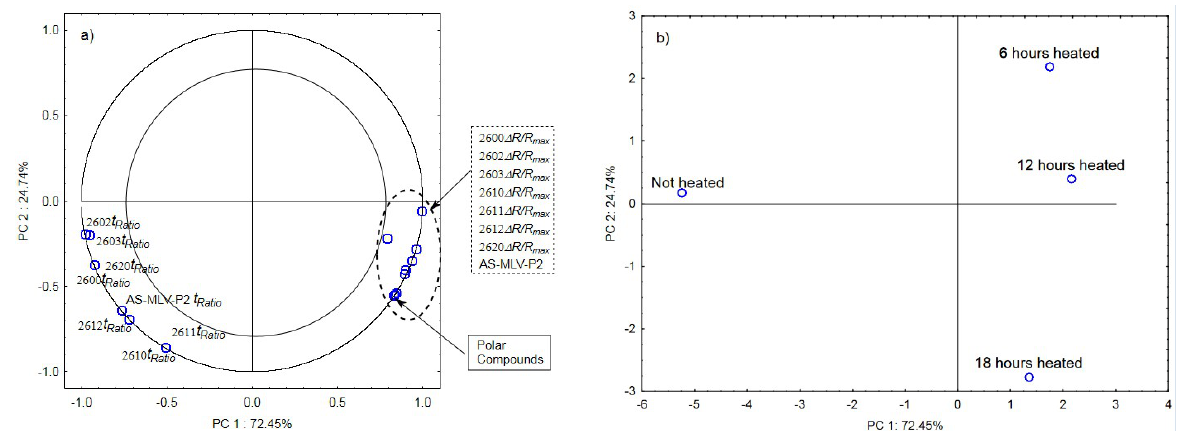
Figure 5. ( a )—Plot of two principal component loadings (PC1, PC2) from eight sensor readings and polar compounds obtained for heated (0.126 s/v ratio) and control oil samples ( ∆ R/R max , t Ratio ; AS brief names of sensors—AS-MLV-P2; 2600, 2602, 2603, 2610, 2611, 2612, 2620—brief names of sensors Figaro—TGS series); ( b )—Plot of two principal component scores (PC1, PC2) from eight sensor readings and polar compounds obtained for heated (0.126 s/v) and control oil samples.